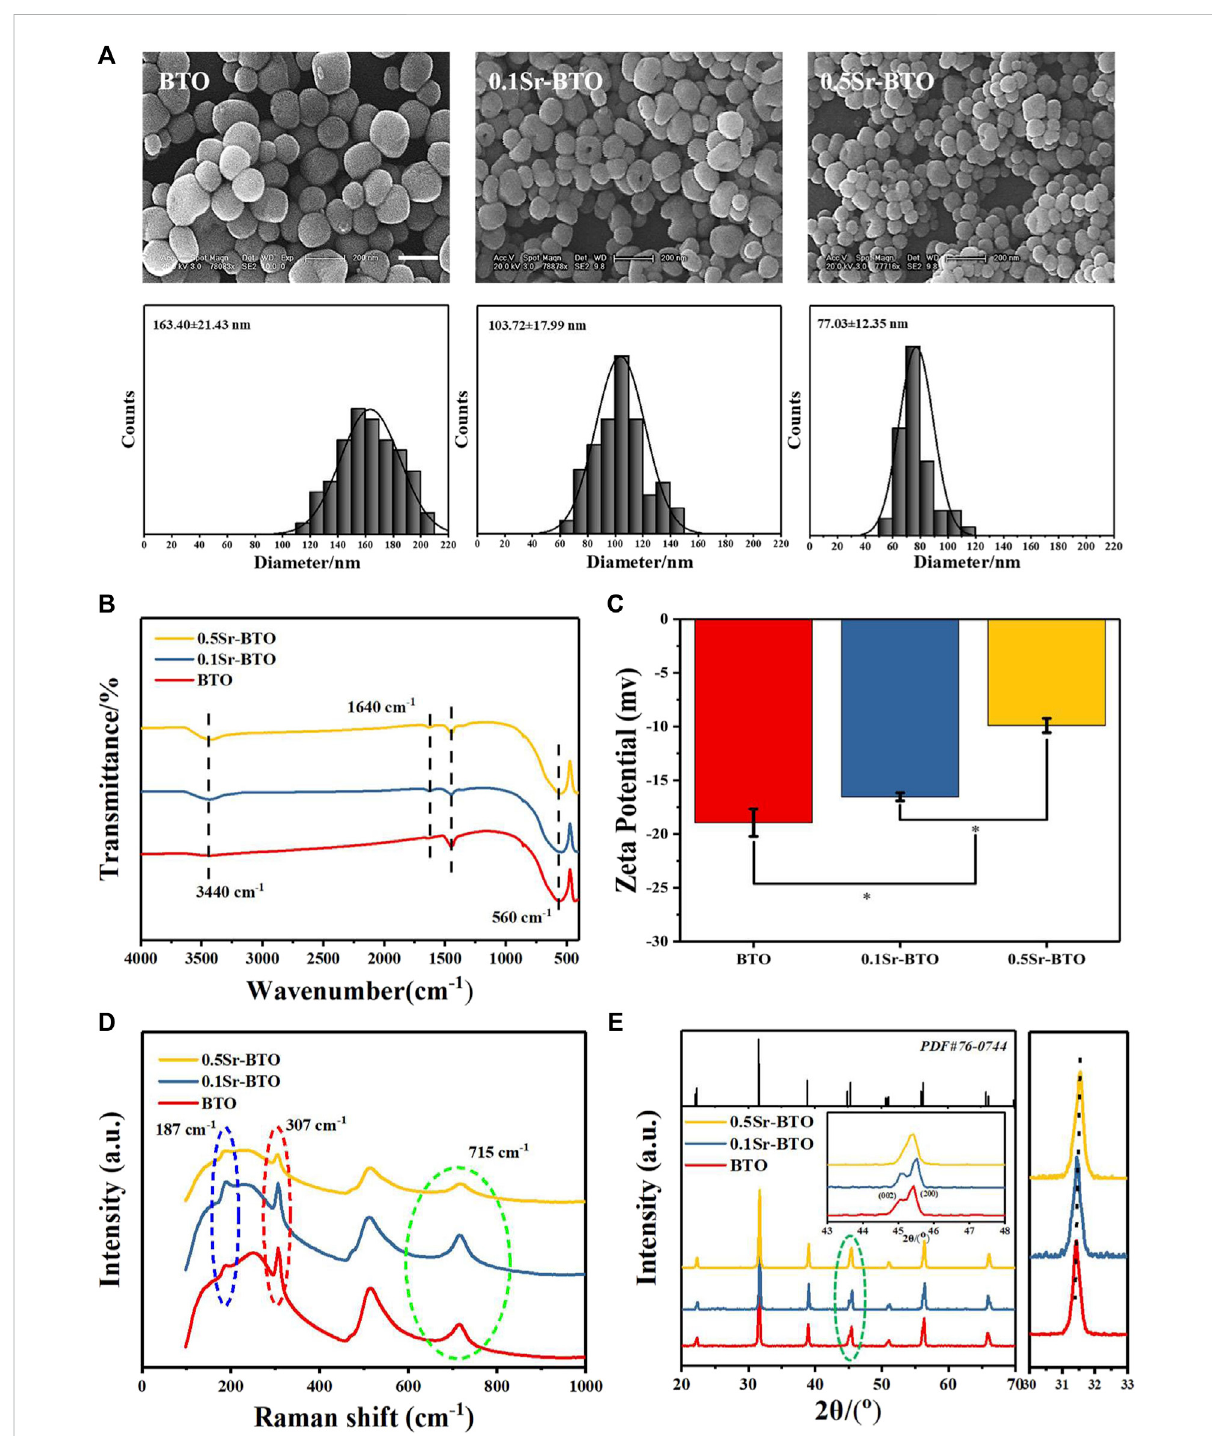
FIGURE 1 (A) SEM images and diameter distribution histograms of BTO and Sr-BTO nanoparticles. Scale bar: 200 nm. (B) FT-IR spectra (C) Zeta potential (D) Raman spectra, (E) XRD patterns (E, left), the XRD step scan from 30 to 33 (E, right) of BTO and Sr-BTO